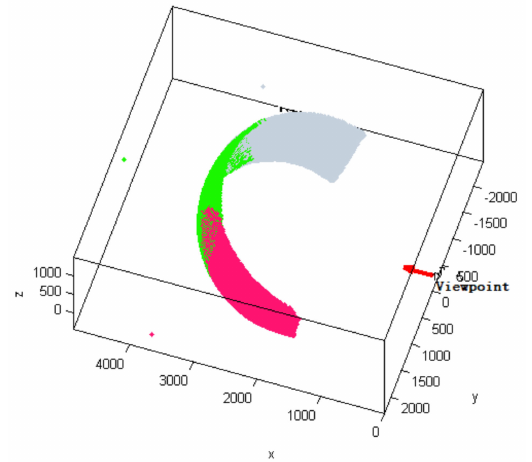
Figure 13. Point cloud matching diagram of the binocular